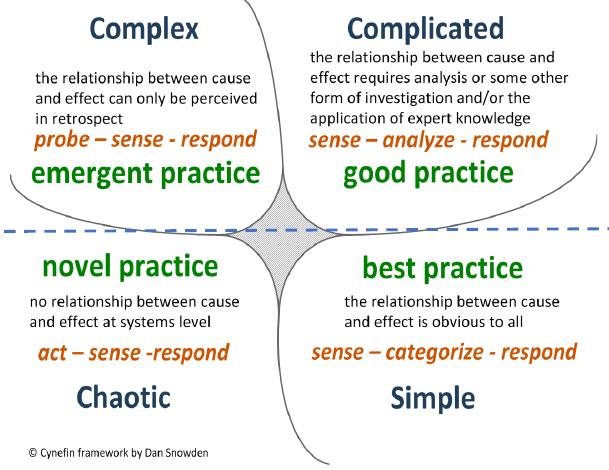
Figure 1. Cynevin framework. Reprinted from Cognitive Edge by D. Snowden, 2010. Retrieved from https://cognitive- edge.com. Reprinted with